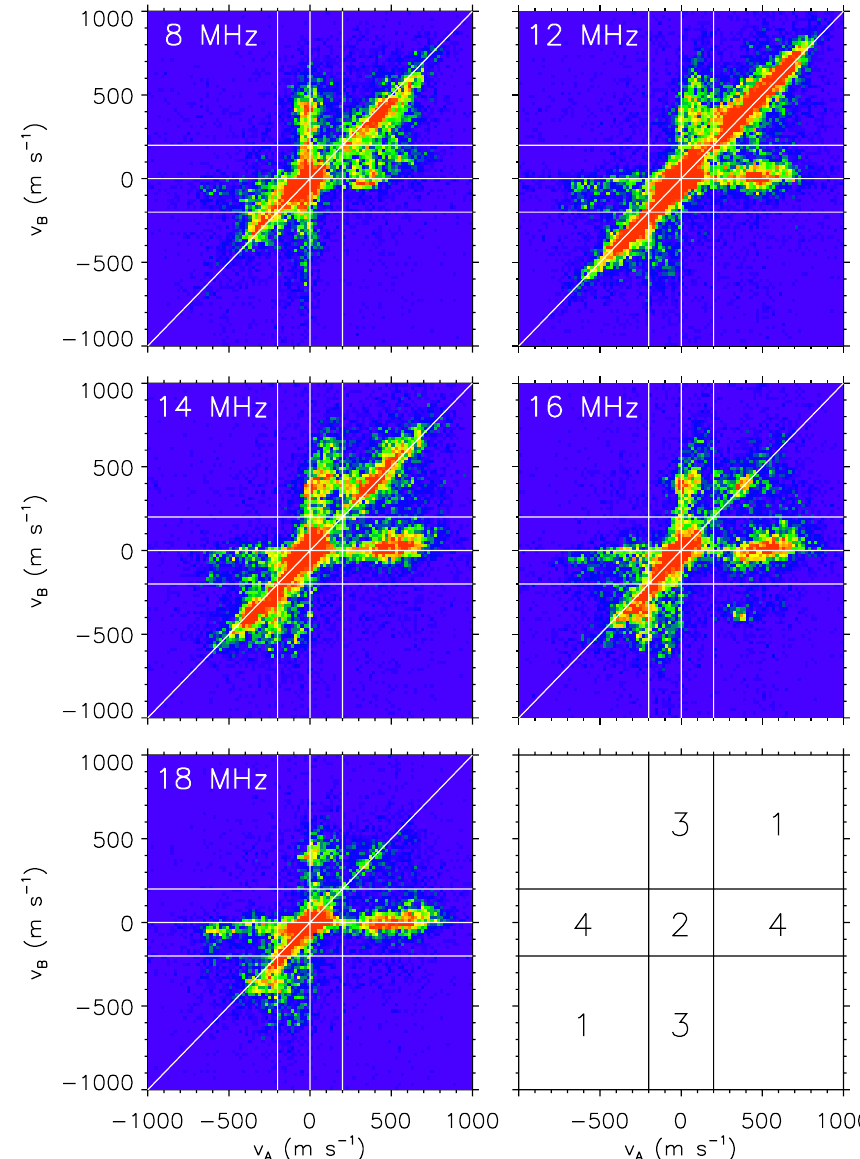
Fig. 8. Occurrence distributions showing the relationship between Doppler shift measured on channel A (ν A ) at 10MHz with Doppler shift measured on channel B (ν B ) in each of the five channel B frequency bands. Red indicates greatest occurrence. The bottom right-hand panel numbers different regions of the distribution plane to aid